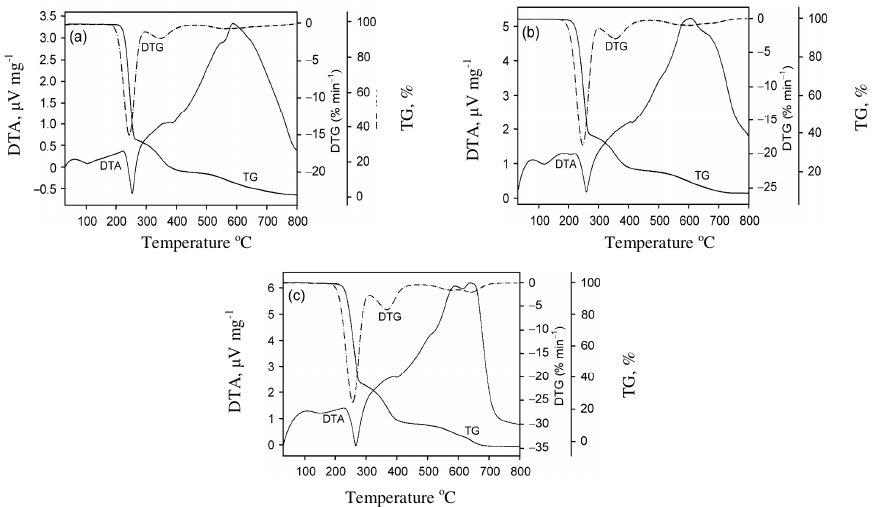
Figure 1. TG, DTA and DTG curves of HBAPPA at a) 10 K min − 1 ; b) 15 K min − 1 and c) 20 K min − 1 heating rates in nitrogen atmosphere.